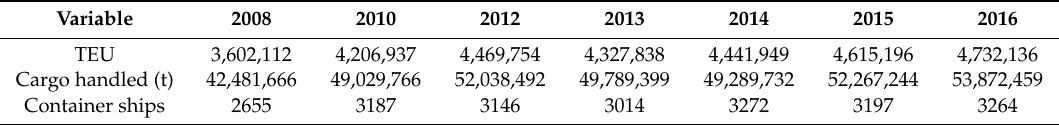
Table 4. TEU, cargo, and container